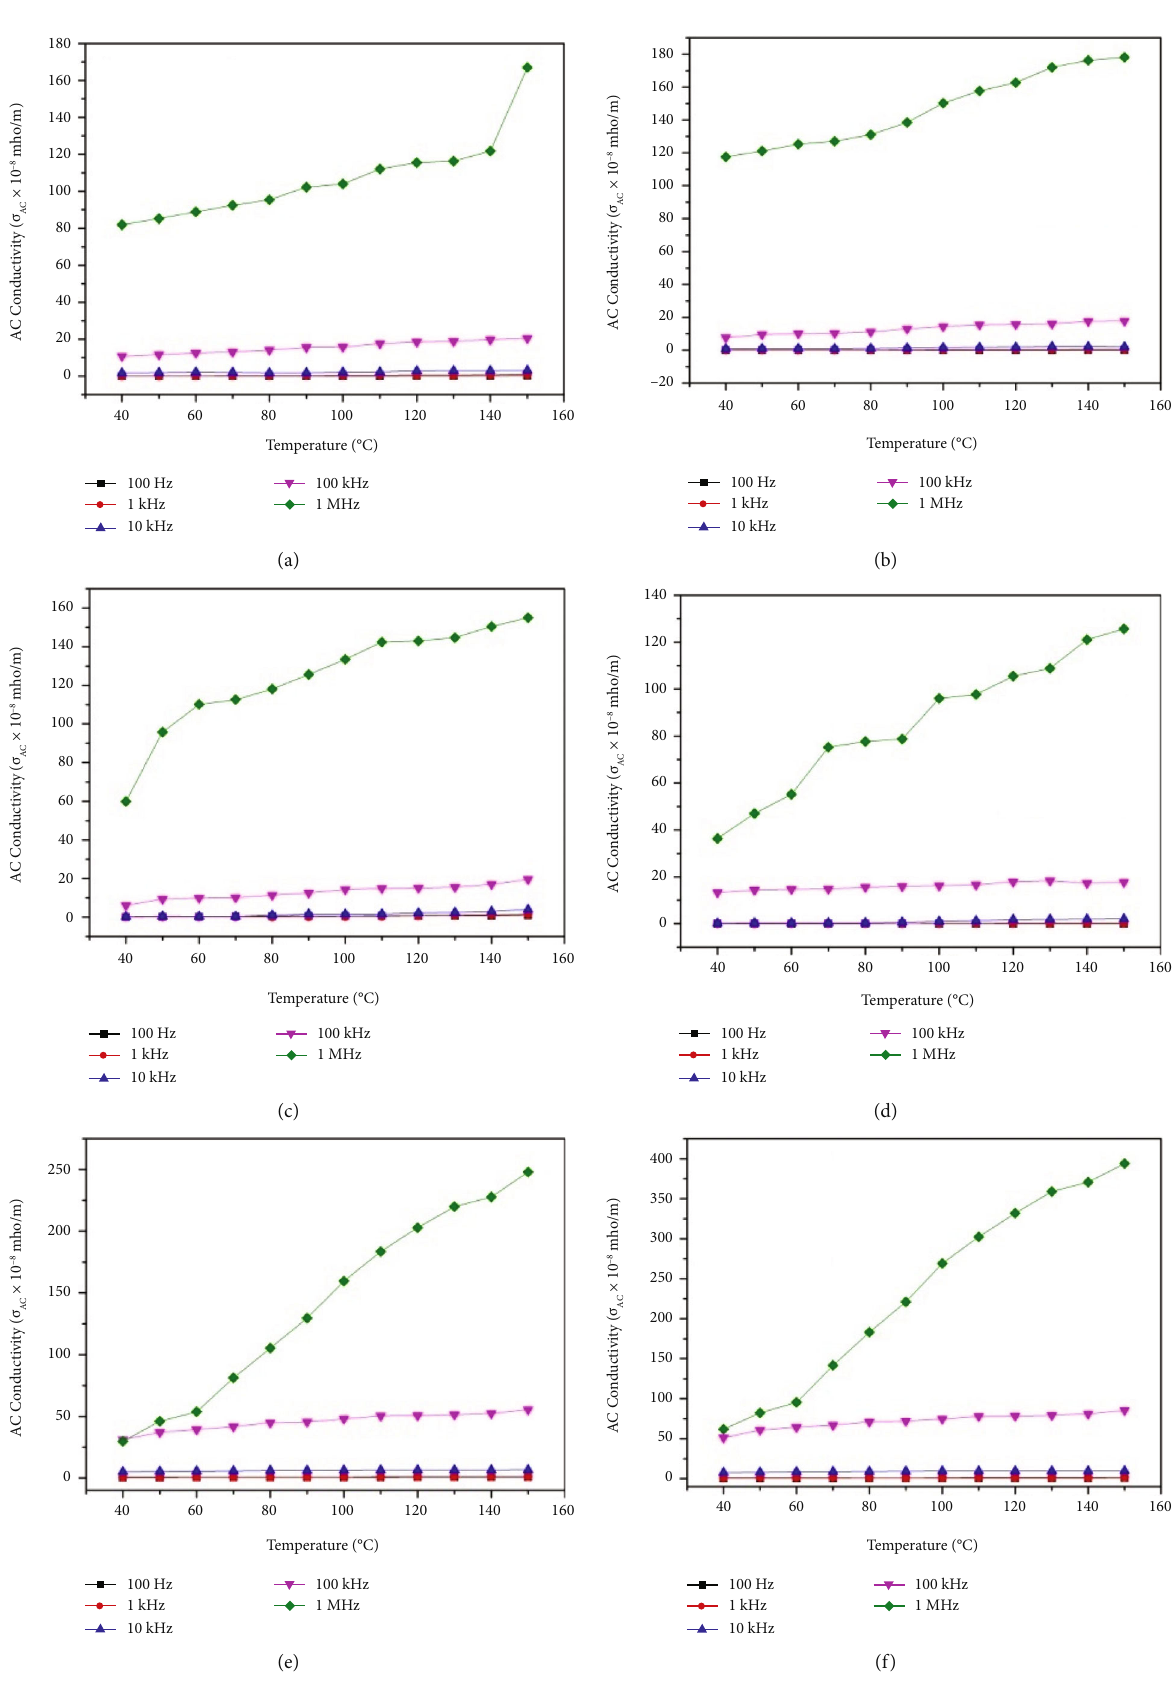
Figure 7: AC conductivity as a function of temperature and frequency for (a) sample A, (b) sample B, (c) sample C, (d) sample D, (e) sample E, (f) sample